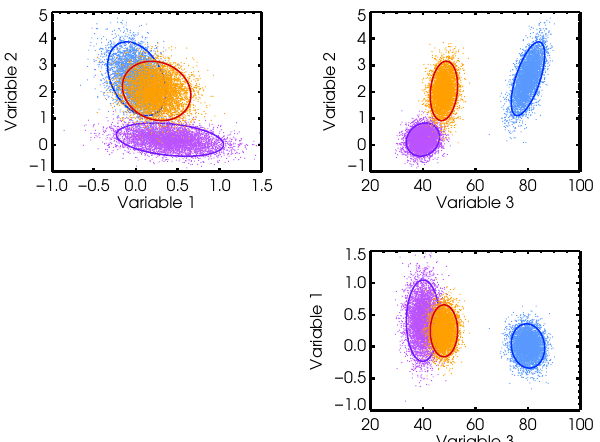
Fig. 1. Illustrates a simulation of mixing in three “measurement” dimensions (Variable 1, Variable 2 and Variable 3) which are shown as 2-D projections in the three panels. Blue and purple indicate two pure types, which are modeled as multivariate normal distributions. The blue and purple points are randomly selected from defined mul- tivariate normal distributions, and the blue and purple ellipses are representations of the two-sigma surfaces of the covariance matri- ces for these distributions. The orange points are constructed nu- merically as linear combinations of points from the purple and blue distributions, using a constant mixing coefficient vector, (0.6, 0.2, 0.8). The red ellipses are the 2-D projections of the covariance ma- trix calculated analytically using Eqs. (30) and (32). The correspon- dence between the red ellipses, calculated analytically, and the or- ange points, calculated numerically, is therefore a demonstration of the correctness of Eq.